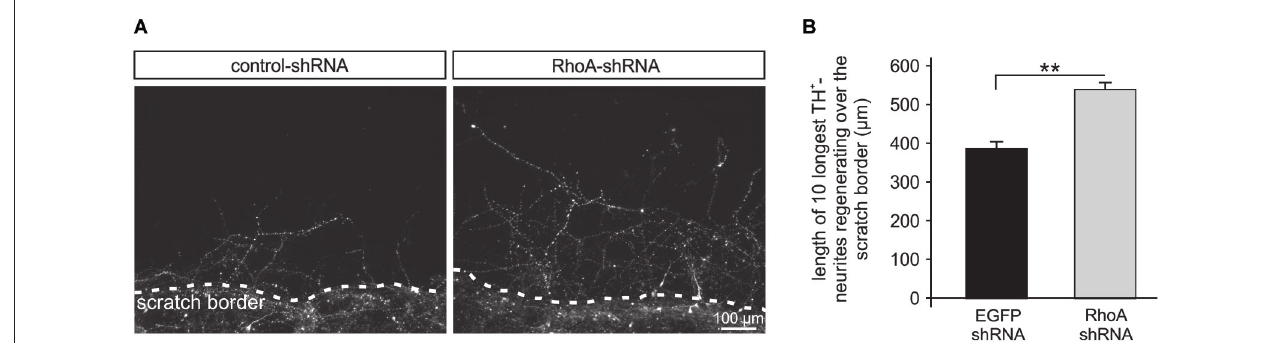
FIGURE 3 | Rho-shRNA enhances neurite regeneration after mechanical scratch lesion . (A) Representative micrographs of primary midbrain neurons (PMN) transduced with AAV expressing the respective shRNA given on top and immunostained against tyrosine hydroxylase (TH). Photos were taken on DIV 6, 72 h after mechanical scratch lesion. The scratch border is shown at the bottom on each picture with neurites growing across the scratch.